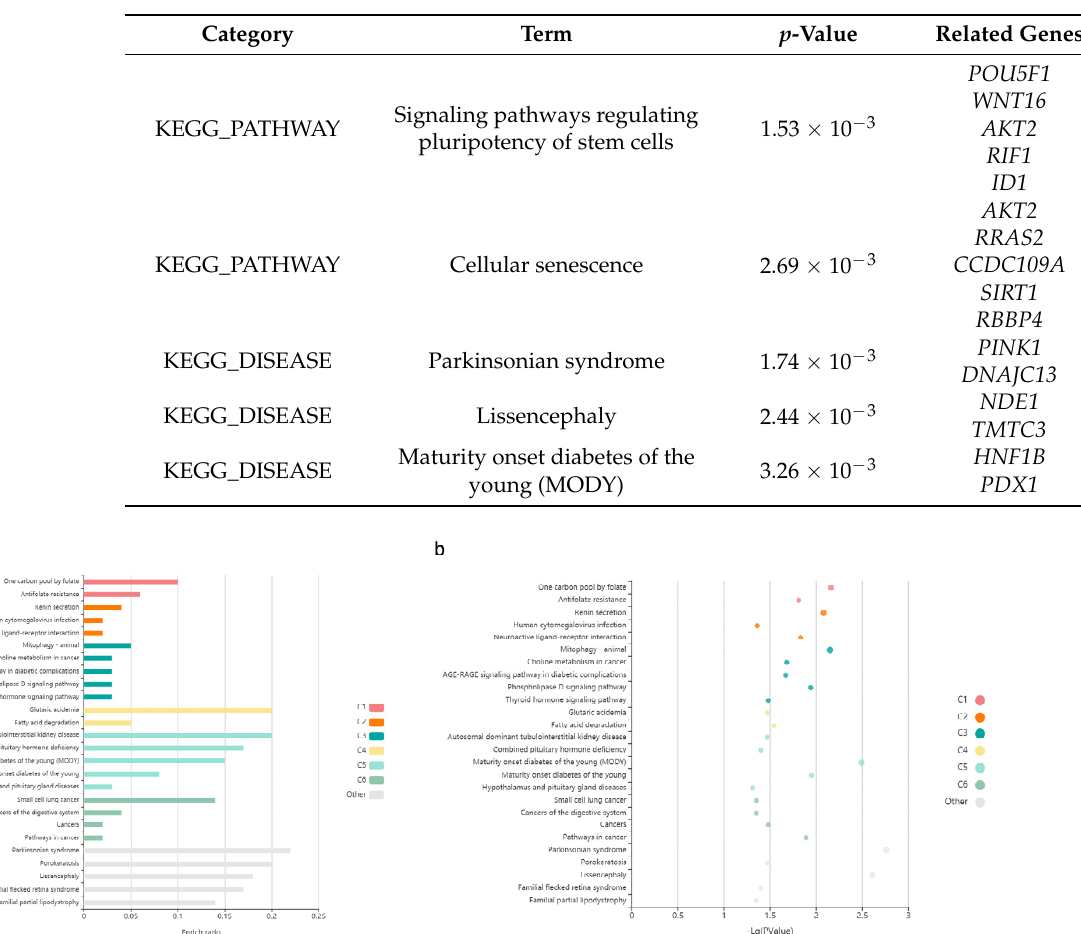
Table 1. The GO enrichment results of differentially methylated genes related to aging (based on SIMPO algorithm).